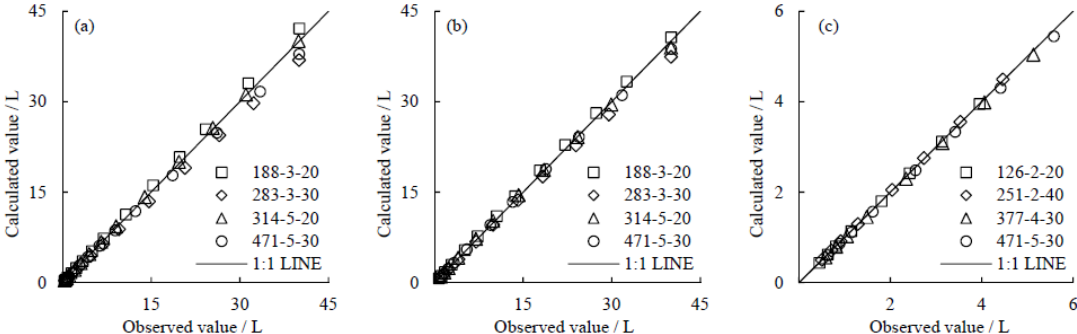
Figure 8. Comparison of the calculated values and observed values of cumulative infiltration of different soils. ( a ): Minqin sandy loam; ( b ): Minqin aeolian sand; ( c ): Shanshan clay loam.